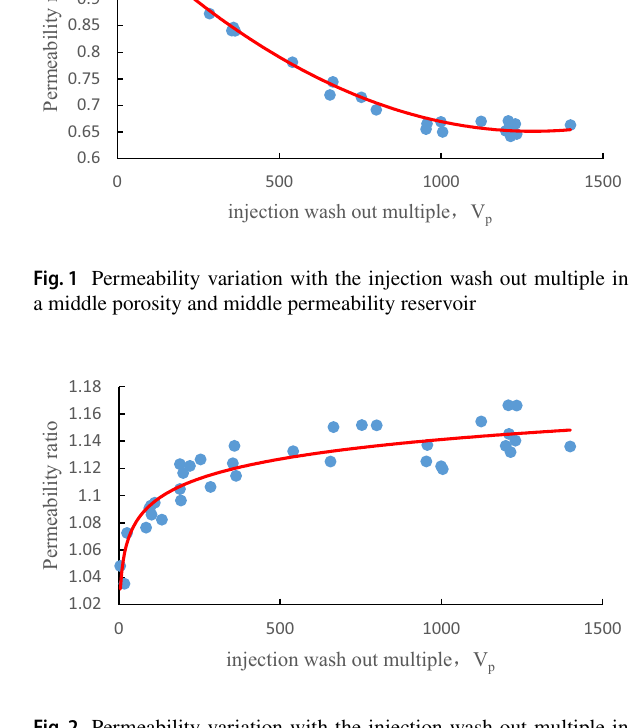
Fig. 2 Permeability variation with the injection wash out multiple in a high porosity and high permeability